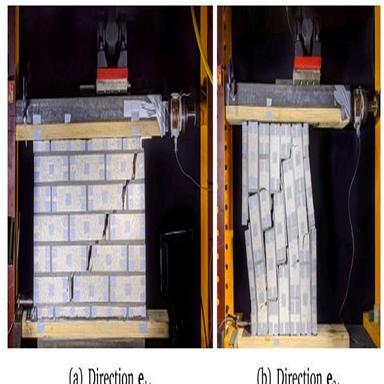
Shear failure of masonry in direction 1 and 2.